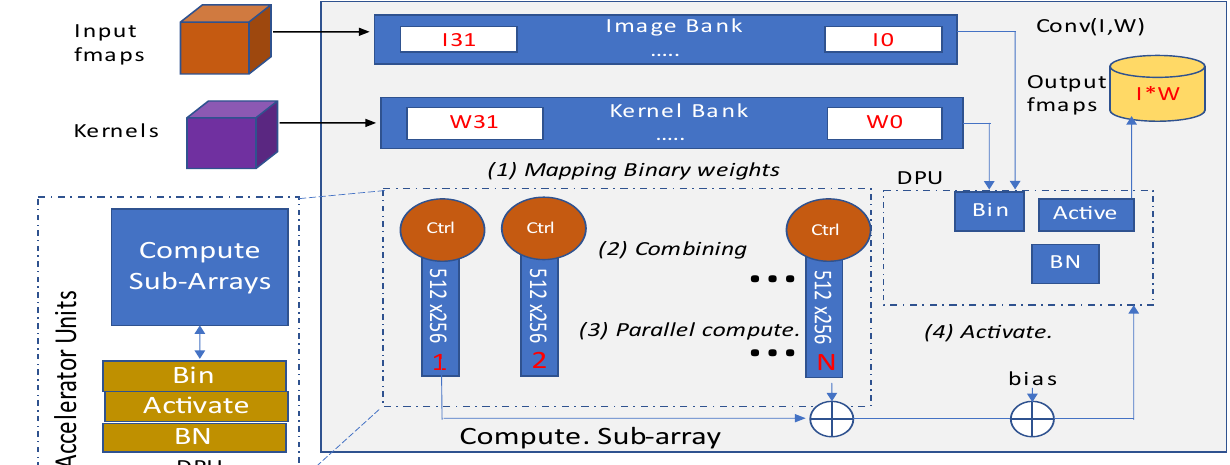
Figure 28. Proposed ParaPIM architecture [14]. The comparison results of different memory architectures on the BWNN model are gathered in [14] for a common task considering batch sizes of 8 and 32 as shown in Figure 29. It is witnessed that ParaPIM is at least 3.9 times a more energy-efficient model than DRAM for batch size 8. Also, when considering a comparison with a ReRAM-based model with batch size 32, ParaPIM comes out as being 13 times more energy efficient. Likewise, the super-fast and in-situ operations place it ahead of other technologies in terms of performance as well.